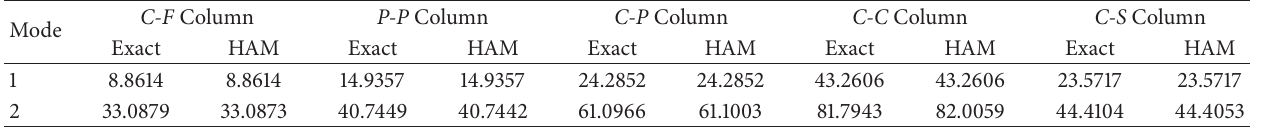
Table 3: Comparison of exact and HAM solutions of the buckling loads for 𝛽 = 50 with ten iterations.